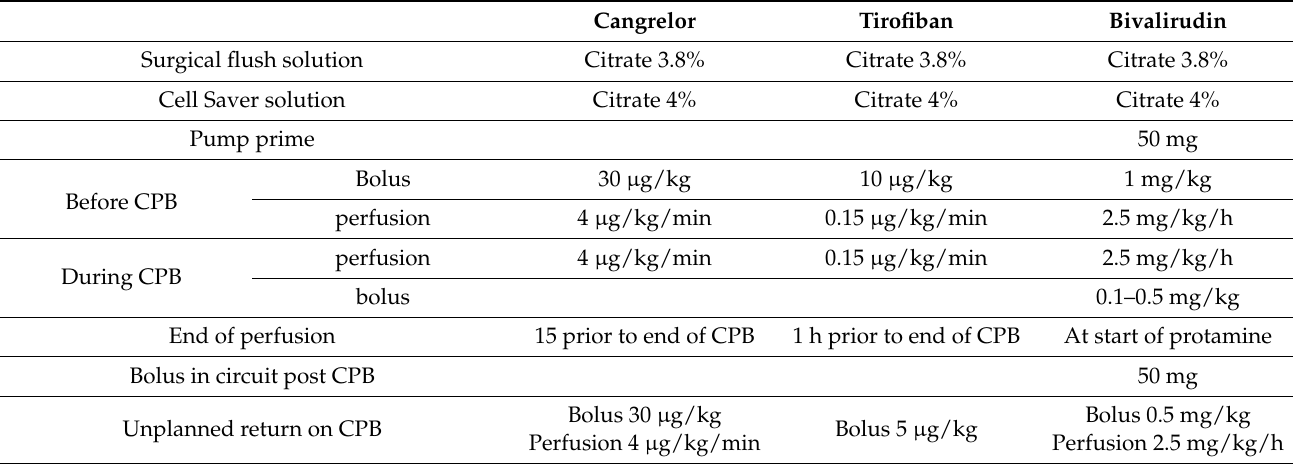
Table 2. Dosing strategies for the various